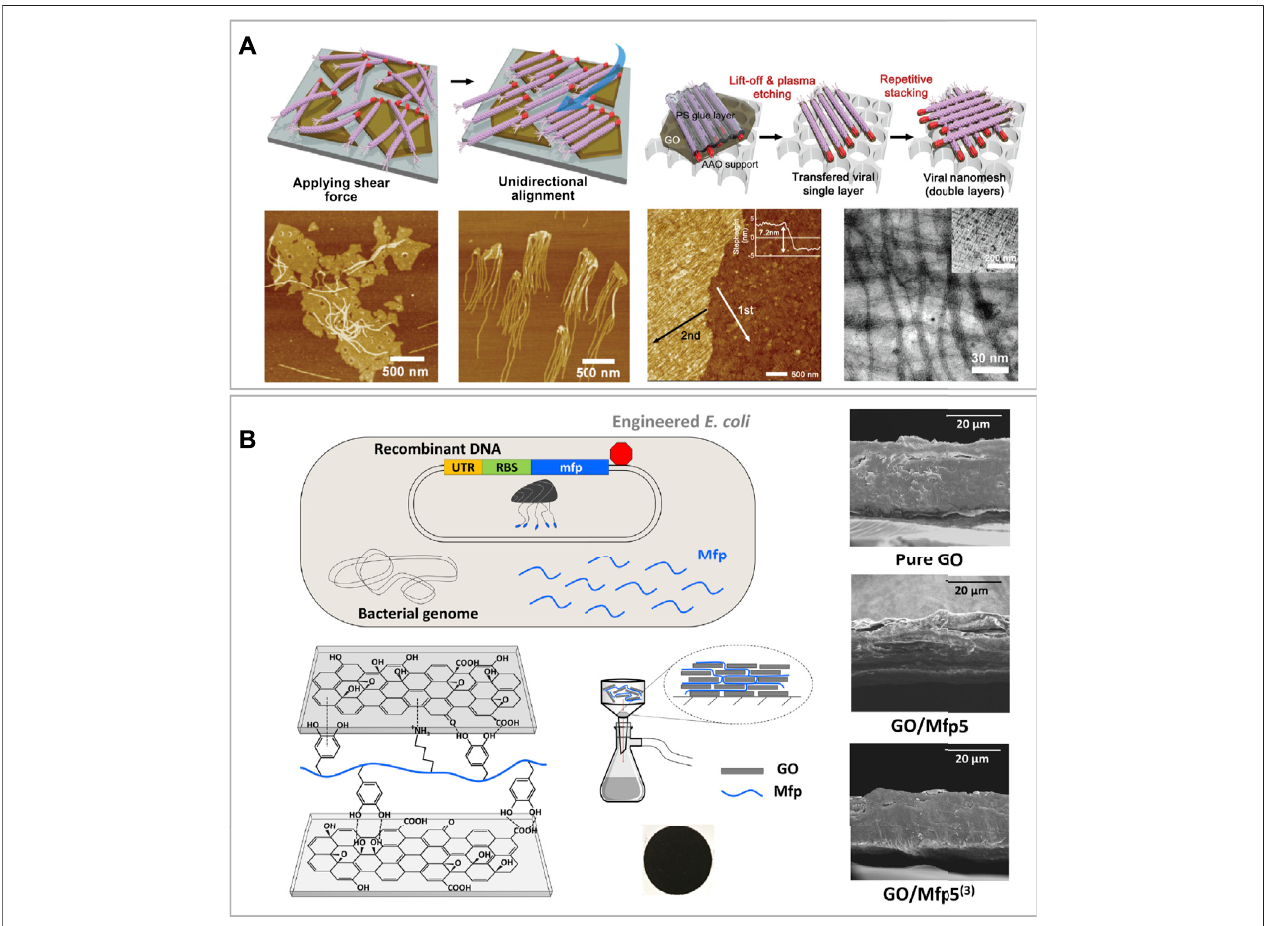
FIGURE 4 | Film-like graphene oxide-based biomaterials (A) Schematic illustration of the unaligned vs. aligned M13 viruses bond onto the edges of GO sheets via the GOBP (red) and below, the corresponding AFM images of the samples. At the right-hand side, the schematic procedure of viral layer transfer and stacking, with corresponding AFM and TEM images of the bilayered viral nanomesh structure. Reprinted with permission (Lee et al., 2014). (B) Schematic of genetically engineered E.coli tooverexpressMfp.Ontheleft-bottomcorner,theschematicofDOPAandlysineresiduesonrecombinant Mfpinteracting withoxygen-functionalgroupsof GO nanosheets and experimental set-up to assemble the GO/Mfp mixture onto a PES support membrane, resulting in a thin fi lm composite (showed below). On the right-hand side SEM cross-section images of the resulting GO/Mfp composite material fi lms made of pure GO, GO/Mfp5 and GO/Mfp5 (3) . Reprinted with permission (Kim et al.,